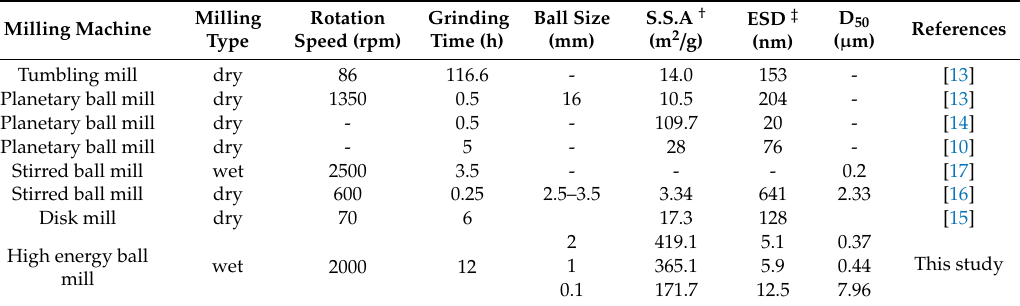
Table 1. Specific surface area and equivalent spherical diameter of talc powder depending on the milling